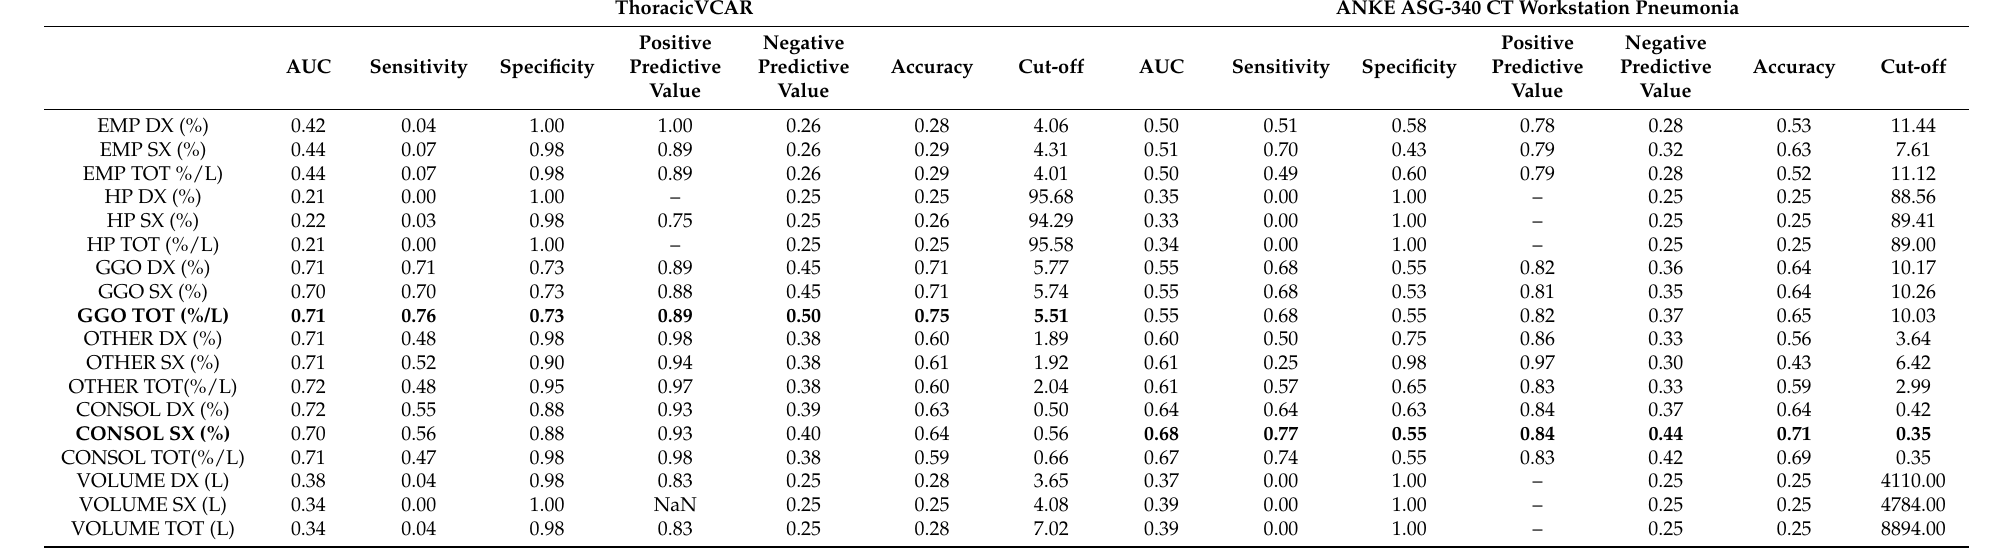
Table 9. ROC analysis results for volumes measurements obtained on baseline CT scans for both